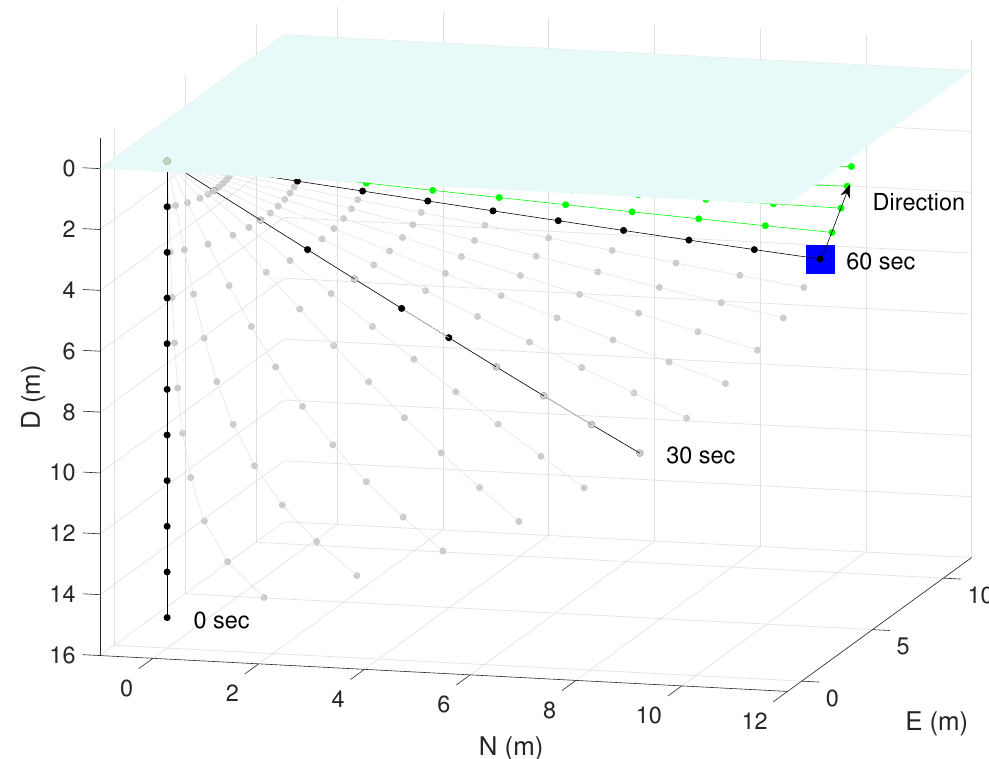
Figure 8. Free floating ROV and tether with a current velocity of [ 0.3536,0.3536,0 ] in the n -frame. Initialized at [0,0,15] in x,y and z, respectively. The blue box represents the ROV at position [9.68,9.94,5.70]. The faded black lines shows the trajectory of the tether and ROV and the green lines show the future path.